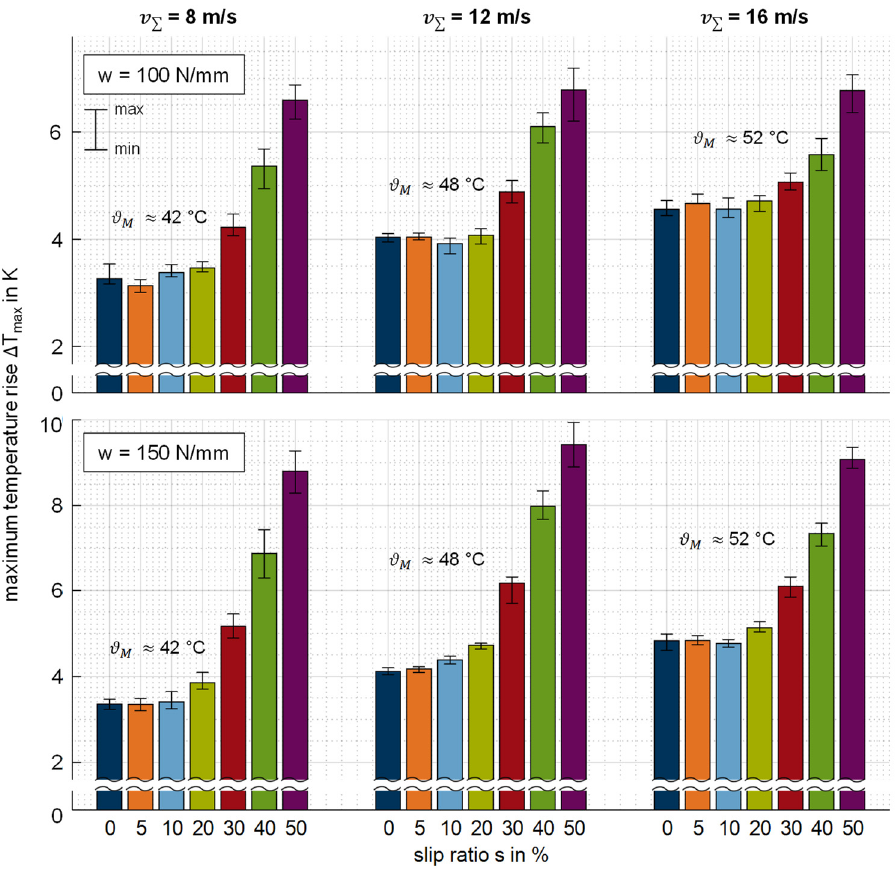
Figure 14. Evaluated maximum temperature rise ∆ T max for the thermoplastic EHL contact ZrO 2 /PEEK in comparison with various line loads w , sum velocities v Σ , and slip ratios s . The maximum temperature rise ∆𝑇 (cid:3040)(cid:3028)(cid:3051) is very similar for slip ratios s = {0; 5; 10}% at all of the loads and speeds considered. This increase occurs at the inlet zone (cf. Section 3.2) and increases with sum velocity 𝑣 ∑ . For slip ratios s > 10%, ∆𝑇 (cid:3040)(cid:3028)(cid:3051) increases with the